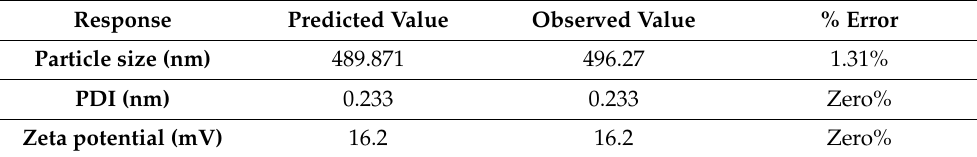
Table 3. Validation of the optimum synthesized ZnO-NPs (F3).